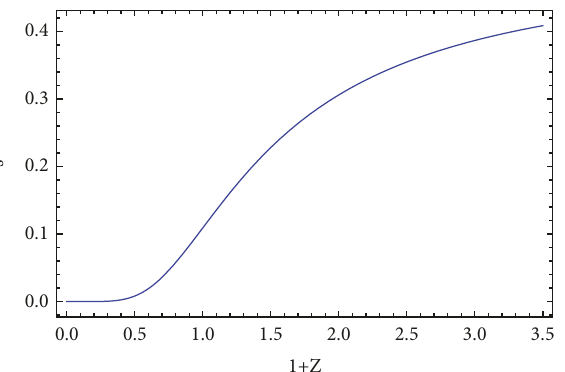
Figure 6: The evolution of the statefinder parameter 𝑠 versus the redshift parameter 𝑧 for noninteracting GDE in DGP model. Here, we have = 0.0003 . taken Ω 𝐷 (𝑧 = 0) = 0.73 , 𝐻(𝑧 = 0) = 67 , and Ω 𝑟 𝑐